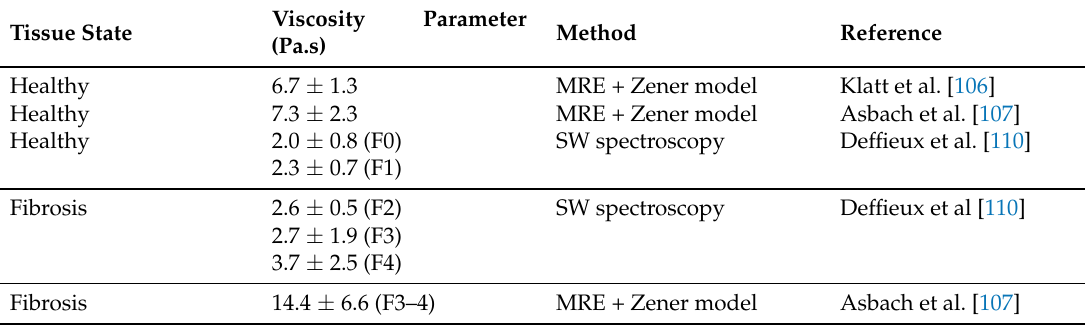
Table 6. Human liver range of viscoelastic biomarkers for healthy state and different grades of fibrosis. Results were obtained using magnetic resonance elastography (MRE) and shear wave pectroscopy (SW spectroscopy). Values are reported as means and standard